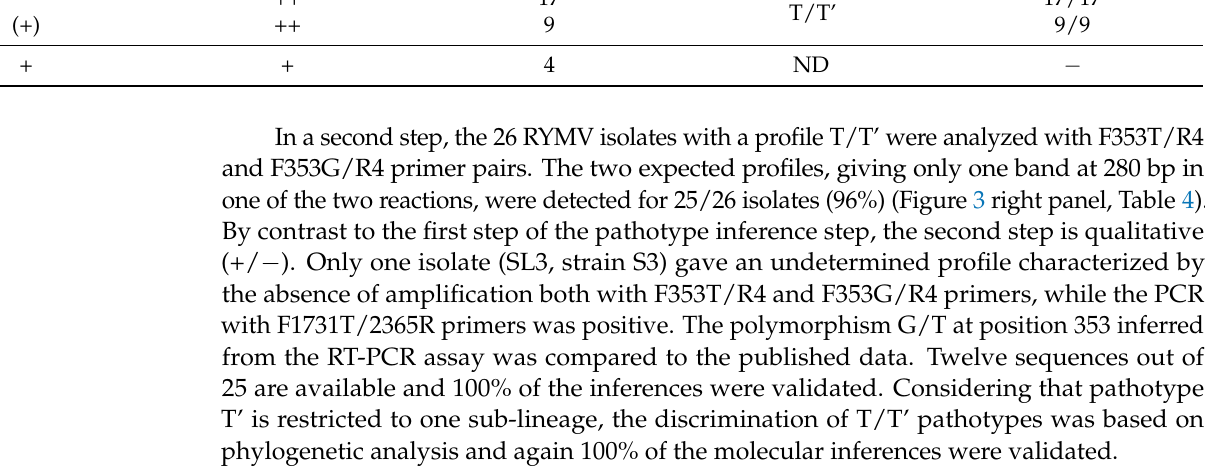
Table 4. RT-PCR pro fi les using F353T or F353G primers, deduced T/T’ pathotypes and sequence Table 4. RT-PCR profiles using F353T or F353G primers, deduced T/T’ pathotypes and validation for 25 isolates. +, presence of a band, − , absence, ND, not determined.